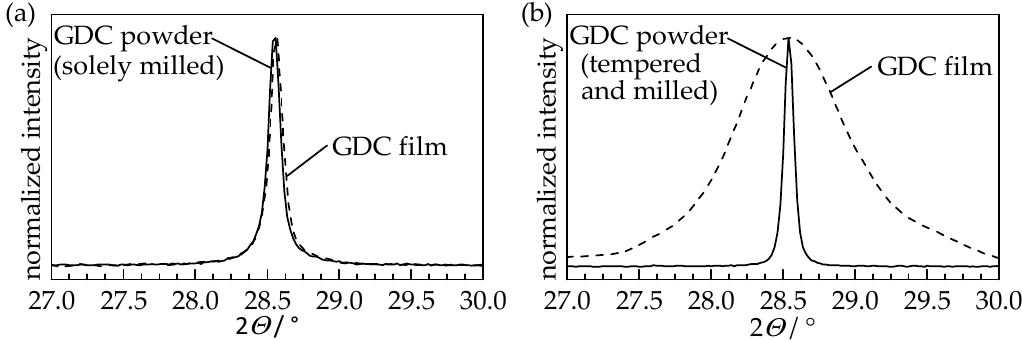
Figure 4. XRD patterns ((111) reflection within the 2 Θ range from 27° to 30°) of GDC10 films